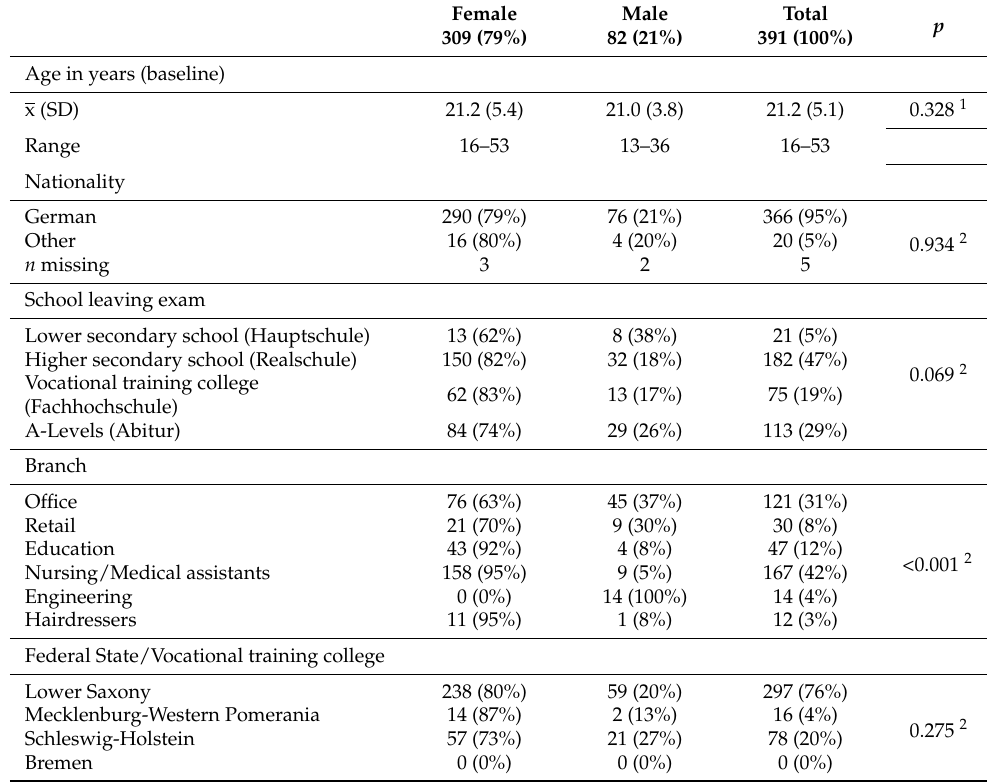
Table 1. Demographic characteristics of the trainee